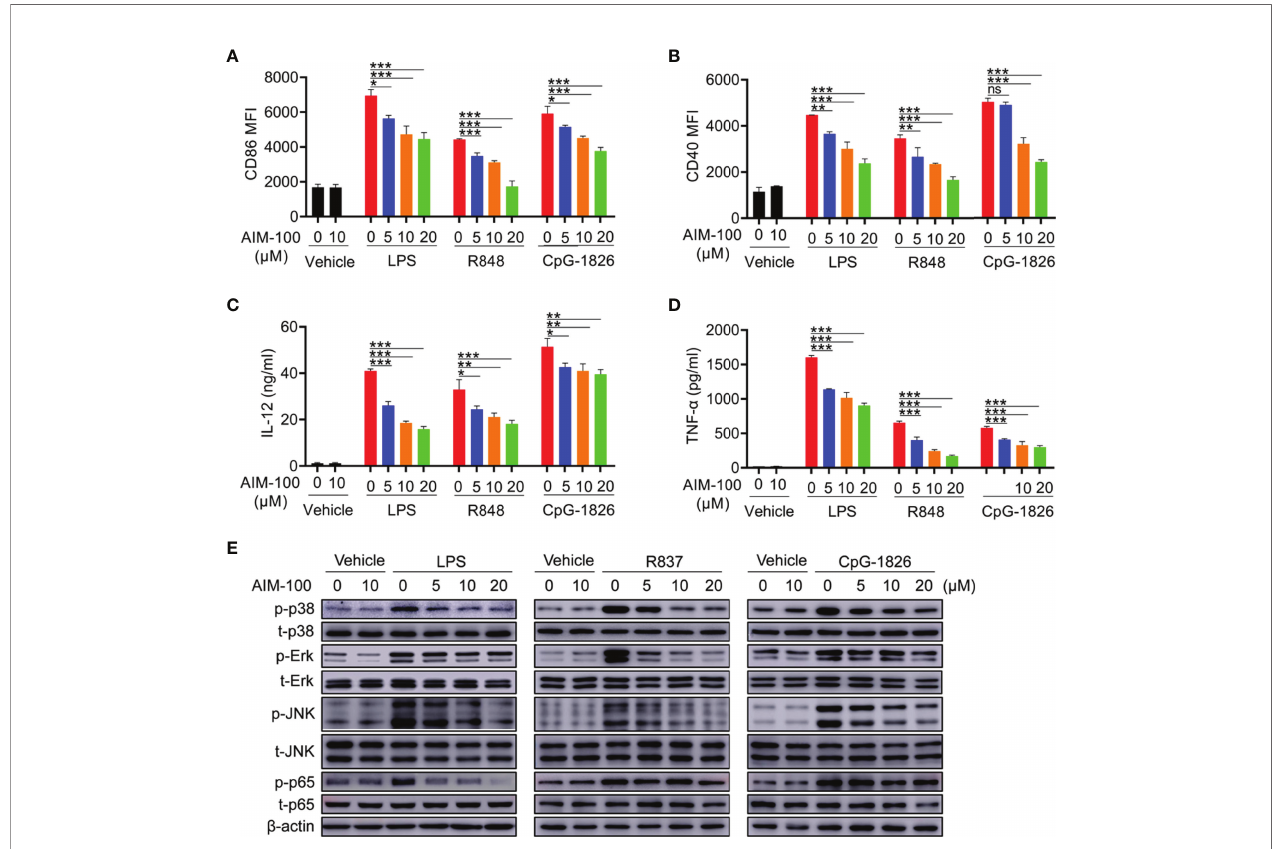
FIGURE 3 | ACK1 inhibitor AIM-100 weakens TLRs-mediated activation of BMDMs. Bone marrow-derived BMDMs from C57BL/6 mice aged 6-8 weeks were pretreated with ACK1 inhibitor AIM-100 (5, 10 and 20 m M) for 2 hours, and were then stimulated with LPS (100 ng/mL), R848 (1 m g/mL) and CpG-1826 (1 m M). FACS analysis of the expressions of CD86 (A) and CD40 (B) on BMDMs at 24 hours. The levels of IL-12 (C) and TNF- a (D) secreted by BMDMs were detected by ELISA at 24 hours. Western blot analysis of the phosphorylation levels of p38, Erk, JNK and p65 at 1 hour (E) . The data shown represent the means of three independent experiments and the error bars represent the S.E.M. * p < 0.05, ** p < 0.01, and *** p < 0.001, as determined by ANOVA tests; ns denotes p > 0.05. b - actin was used as loading